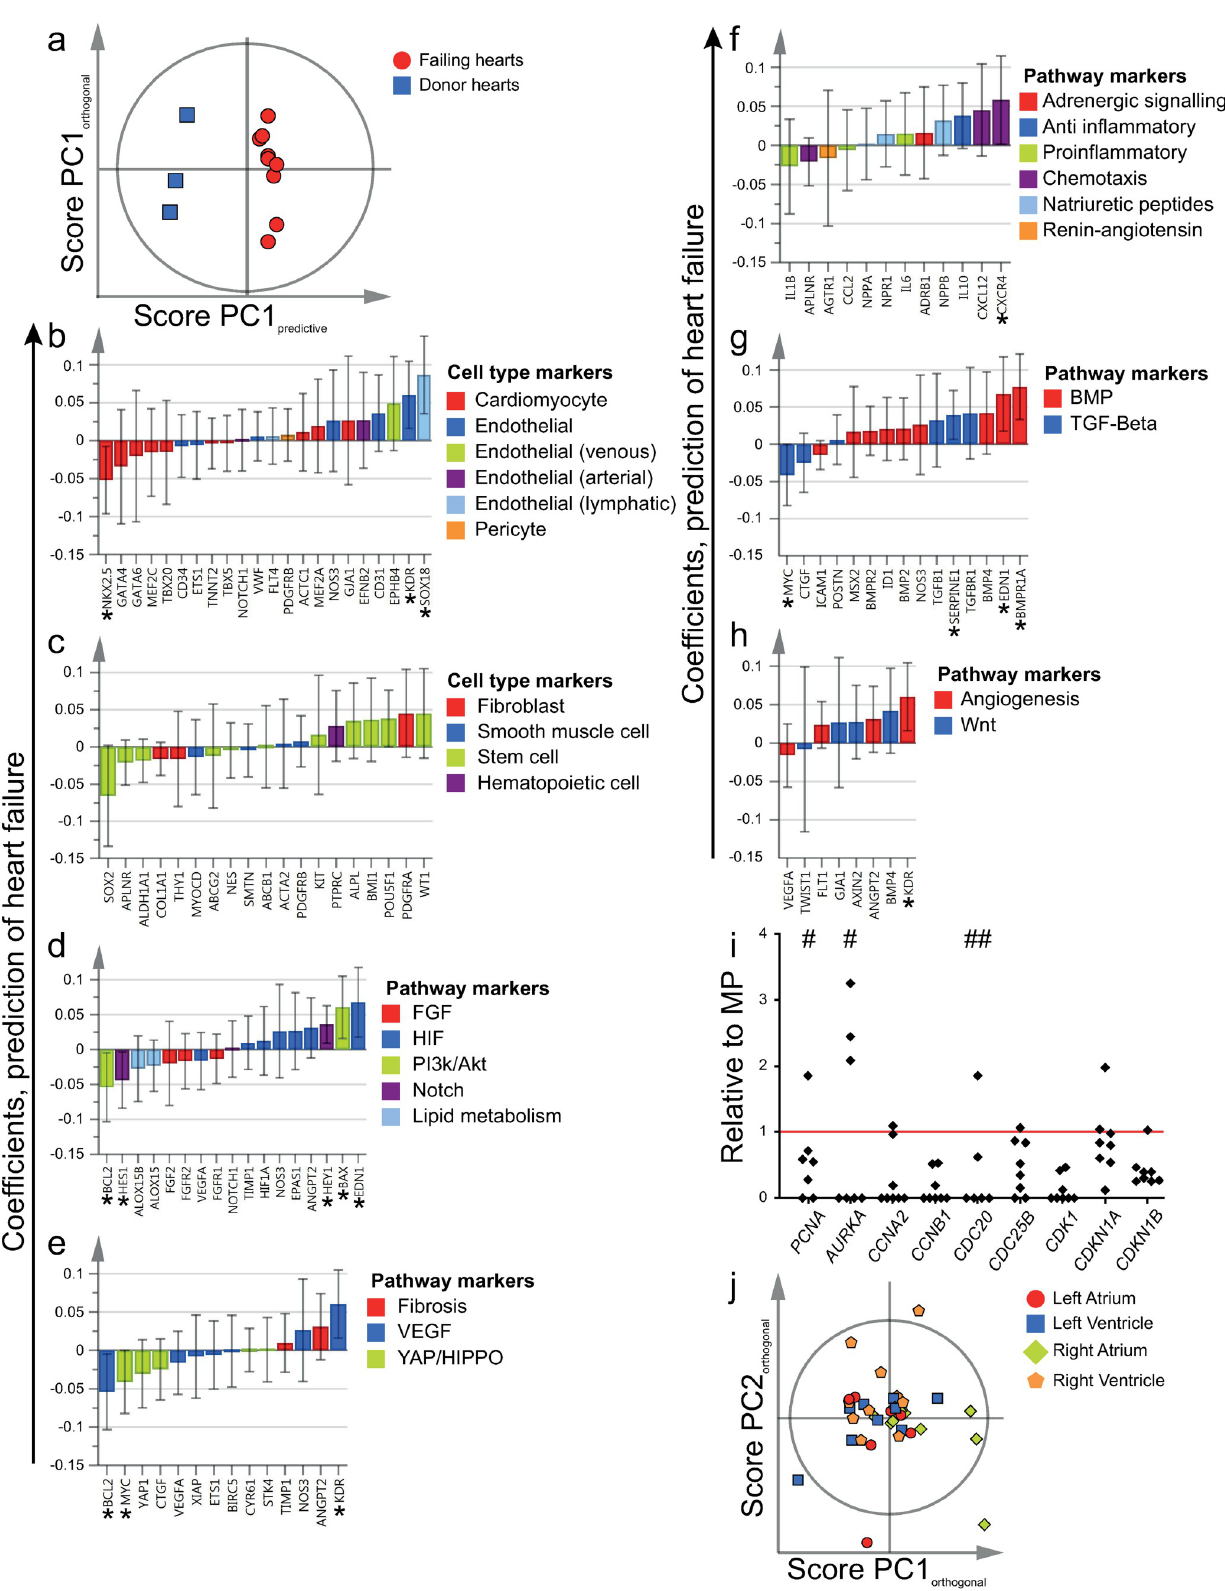
Fig 7. Differences based on heart failure, location and expression of cell cycle regulators. a) SSEA4+CD34- cells from failing and donor hearts were included in an OPLS-DA model (included independent cell population datasets = 12). Clustering of SSEA4+CD34- cells, as demonstrated by the predictive PLOS ONE | https://doi.org/10.1371/journal.pone.0269985 June 16,